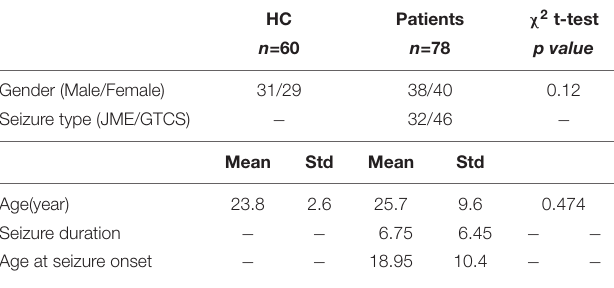
TABLE 1 | Summary demographic of patients and healthy